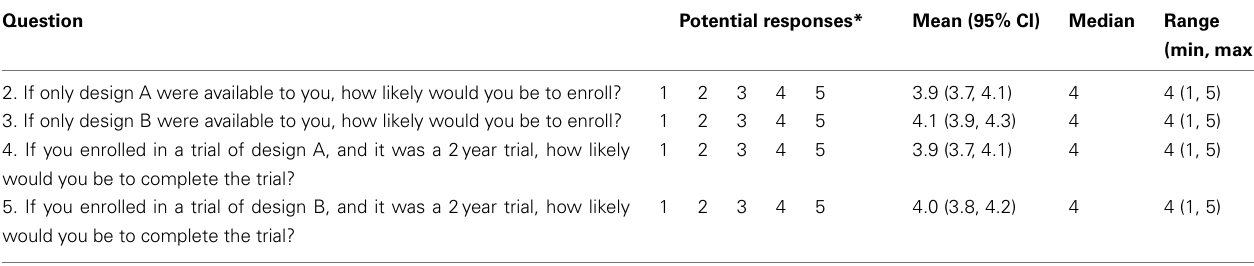
Table 2 | Survey questions, potential responses, and summary statistics of responses.